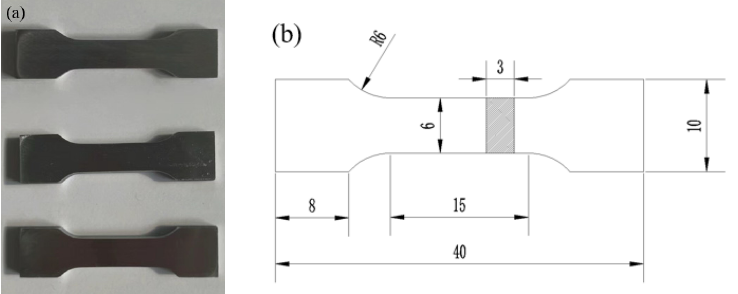
Figure 3. Schematic diagram of the tensile test specimen: ( a ) physical drawing, ( b ) dimension draw- ing.